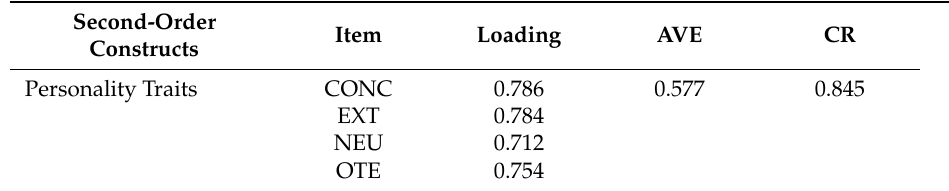
Table 4. Measurement Model for Second-Order Construct.